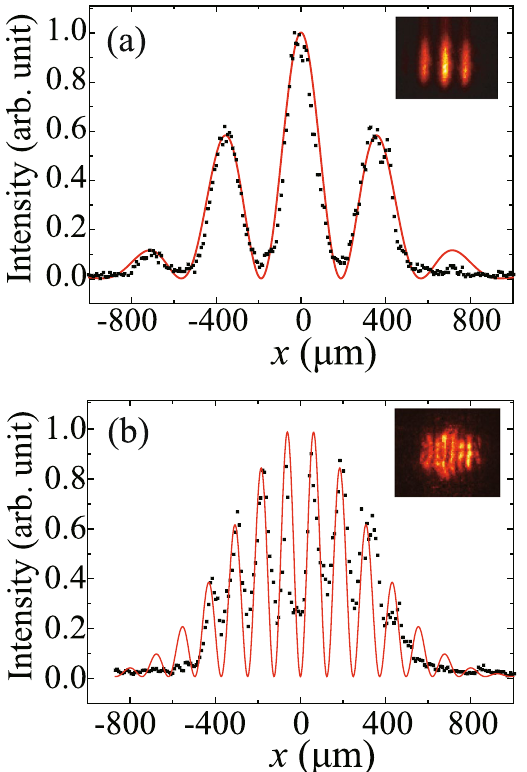
Figure 3. The transverse intensity profiles of the interference pattern for the input signal field E S ( a ) and the retrieved output signal field E S ′ with an effective wavelength of λ /3 ( b ) in the rear focal plane of lens L1. The slit width a and the separation distance d of the double-slit are 200 μ m and 500 μ m, respectively. The insets show the corresponding intensity distribution recorded by ICCD through lens L2. The black squares are the experimental data, and the red solid curves are theoretical simulation using Eq. (2) for ( a ) and Eq. (5) for ( b ), respectively, with experimental parameters and without any fitting